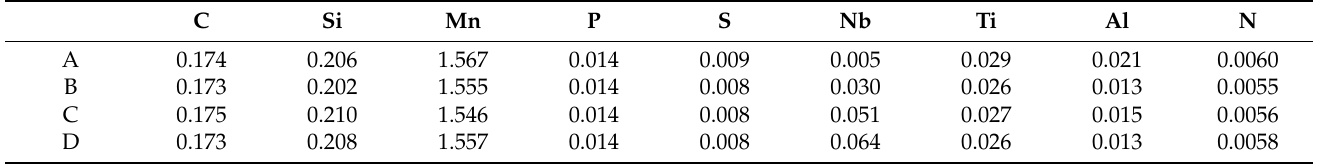
Table 2. Chemical composition of high-rise structural steel with different Nb contents (wt